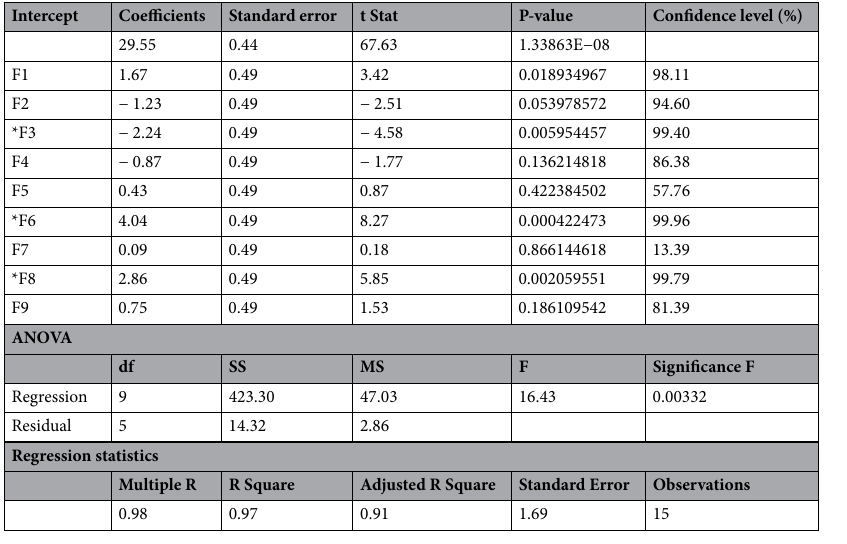
Table 4. Regression statistics and analysis of variance (ANOVA) for Plackett–Burman design. *Denotes a statistically significant difference between the test factors.